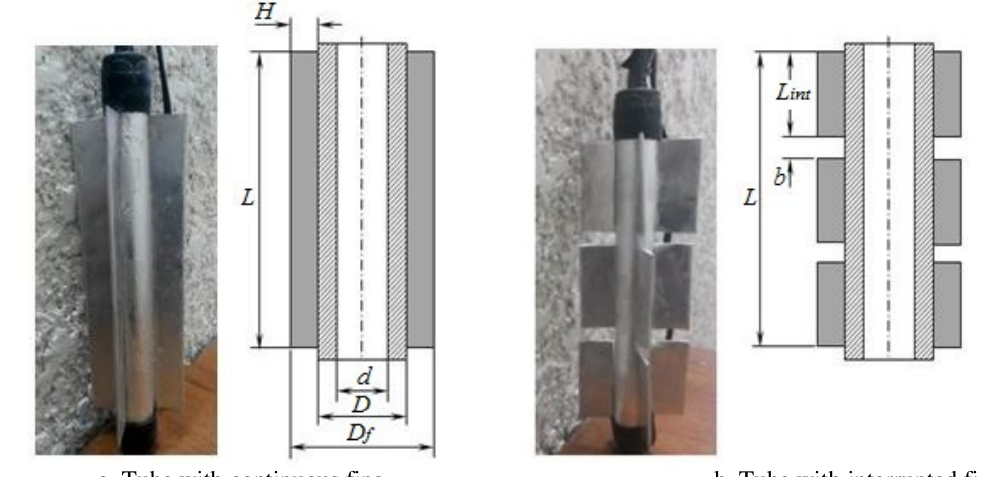
Fig. 1. Experimental-setup.